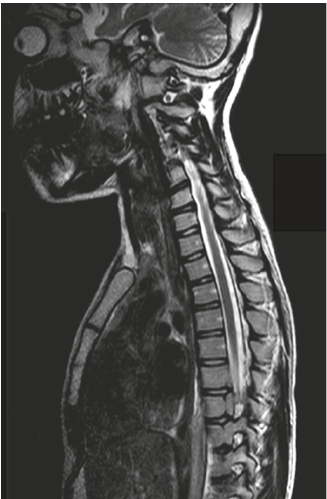
Figure 1: Rachis MRI detecting the presence of GAG around the dens of the epistropheus and the anomalies of spinal canal’s diameter.